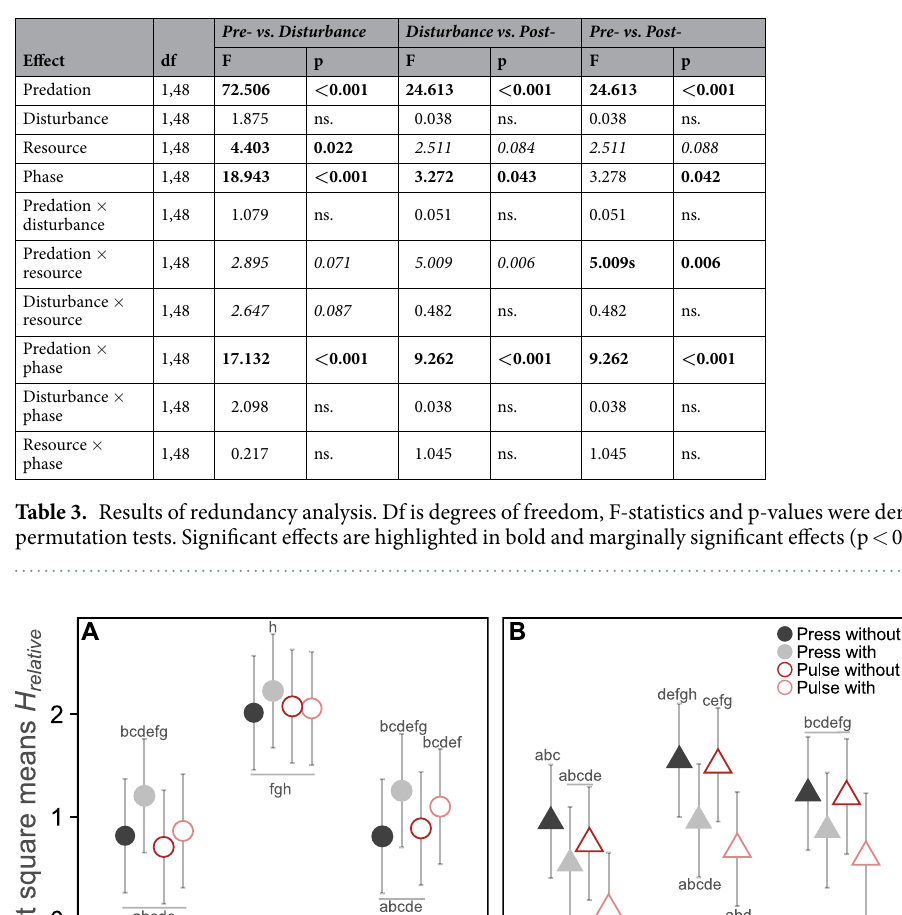
Figure 3. Magnitude of change in prey diversity (H) relative to the control under different disturbance treatments in the absence ( A ) or presence ( B ) of a predator. Colors code for the disturbance treatments, “press” and “pulse” are the disturbance types, “with” indicates that the disturbance is coupled with a resource deprivation and “without” is without resource deprivation. Points represent least square means for each treatment and the error bars are the 95% confidence intervals. Bonferroni-Holm corrected multiple comparisons are shown as letters. Groups sharing the same letter are not detectably different.